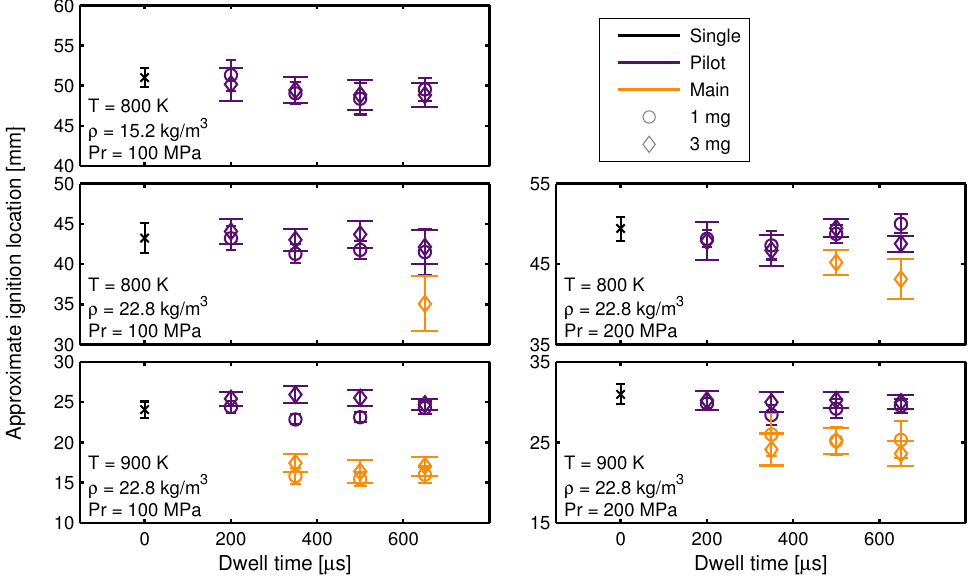
Figure 11. Ignition location results for pilot-main strategies and all conditions in which ignition occurred within the field of view. Error-bars represent shot-to-shot dispersion, depicting a different cap size for the 3 mg (wider) and 1 mg (narrower)